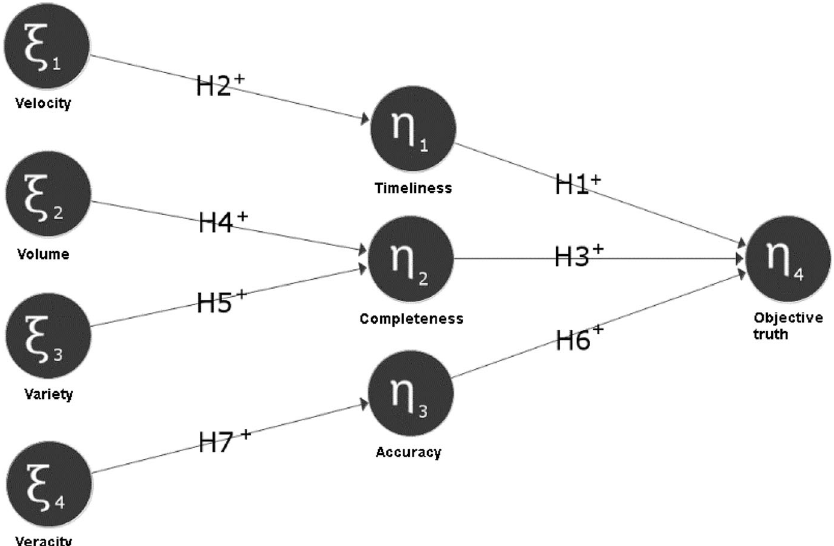
Fig. 1 Derived structural equation model without measurement